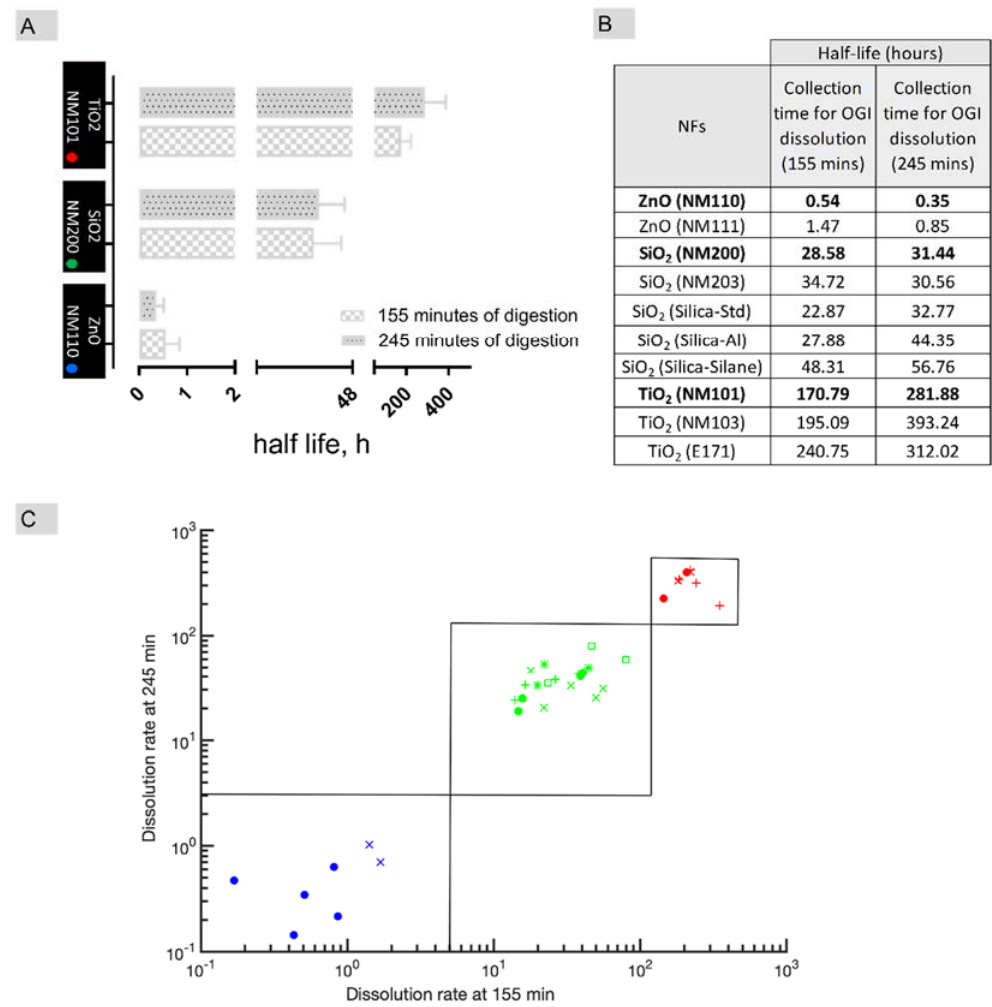
Figure 6. A case study to test the suitability of the oral IATAs for grouping of NFs. ( A ) Histograms report the dissolution half-life (t 1/2 ) of benchmarks materials (ZnO NM110, SiO 2 NM200 and TiO 2 NM101) measured after 155 min and 245 min of OGI digestion. Data are expressed in hours and as mean ± standard deviation ( n = 4). ( B ) Table reporting the average half-life values of benchmarks (in bold) and target NFs in simulated OGI fluids. Data are expressed in hours ( n = 4). ( C ) NFs are represented on a logarithmic 2D graph having the half-life of OGI digestion estimated after 155 min and 245 min on the x- and y-axes, respectively. The points corresponding to different NFs are represented according to a colour code based on composition (Titanium-based in red, Silica-based in green and Zinc-based in blue). Closed red circles refer to NM101; red crosses refer to NM103, red plus refers to E171; Closed green circles refer to NM200; green crosses to NM203, green plus refers to Silica_sd; green asterisk refers to Silica_Al; green square refers to Silica_Silane; closed blue circles refer to NM110 and blue crosses refer to NM111. In the scatter plot, the main component of the NF is clearly the main determi ‐ nant for the clustering of the points, as sketched by solid line rectangles.